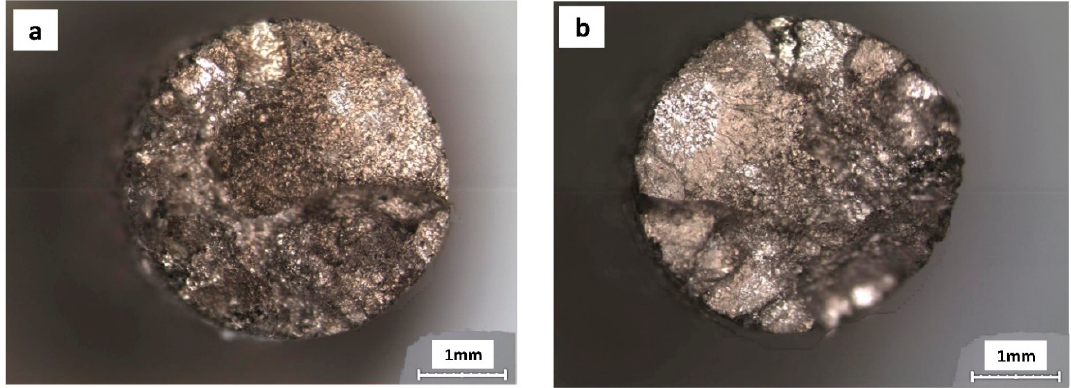
Figure 7. The typical fracture surface obtained after SSRT analysis at a strain rate of 2.5 × 10 − 6 s − 1 in PBS solution: ( a ) Mg-5Zn-1Nd and ( b ) Mg-5Zn-2Nd.